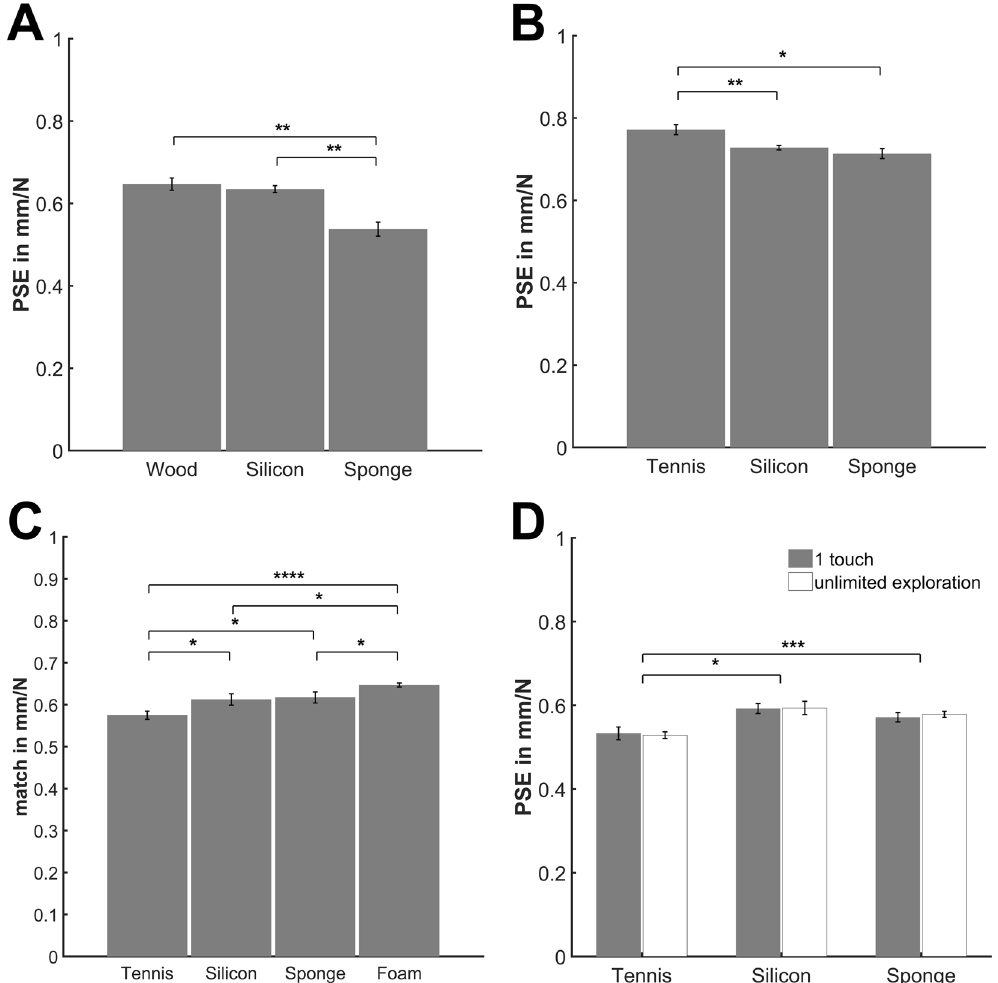
Figure 2. Average PSEs and matches. ( A ) Experiment 1: Average perceived softness of an uncovered silicon standard measured with comparison stimuli covered with a layer of wood, sponge or uncovered. It is predicted that the standard will be perceived equal to harder comparisons when they are covered with the sponge and to softer comparisons when they are covered with the wood as compared to when they are uncovered. ( B ) Experiment 2: Average perceived softness of an uncovered silicon standard measured with comparison stimuli covered with a layer of a tennis ball, sponge or uncovered. It is predicted that the standard will be perceived equal to harder comparisons when they are covered with the sponge and to softer comparisons when they are covered with the tennis ball as compared to when they are uncovered. ( C ) Experiment 3: Average matches of a silicon rubber standard with a foam ball, a sponge, a tennis-ball cover or no cover to uncovered silicon rubber comparisons. It is predicted that the standard will be perceived harder when covered with the tennis ball and softer when covered with the sponge or foam ball as compared to when being uncovered. (D) Experiment 4: Average perceived softness of a silicon stimulus covered with a layer of a tennis ball, sponge or uncovered measured with uncovered silicon comparisons and differently long explorations of the stimuli (one touch or unlimited). It is predicted that the standard will be perceived harder when covered with the tennis ball and softer when covered with the sponge as compared to when being uncovered with effects being smaller with a long exploration. Error bars represent the within-subject standard error 60 . * p < 0.05; ** p < 0.005; *** p < 0.0005; **** p <